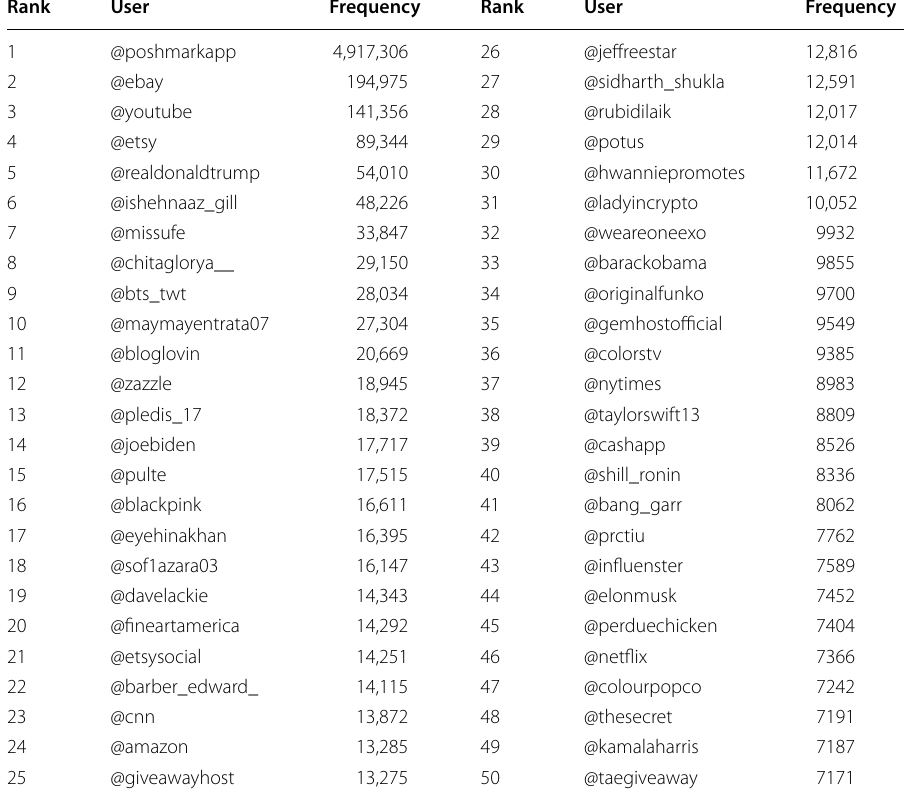
Table 5 Top‑50 popular user mentions from the tweets posted by the young female users interested in